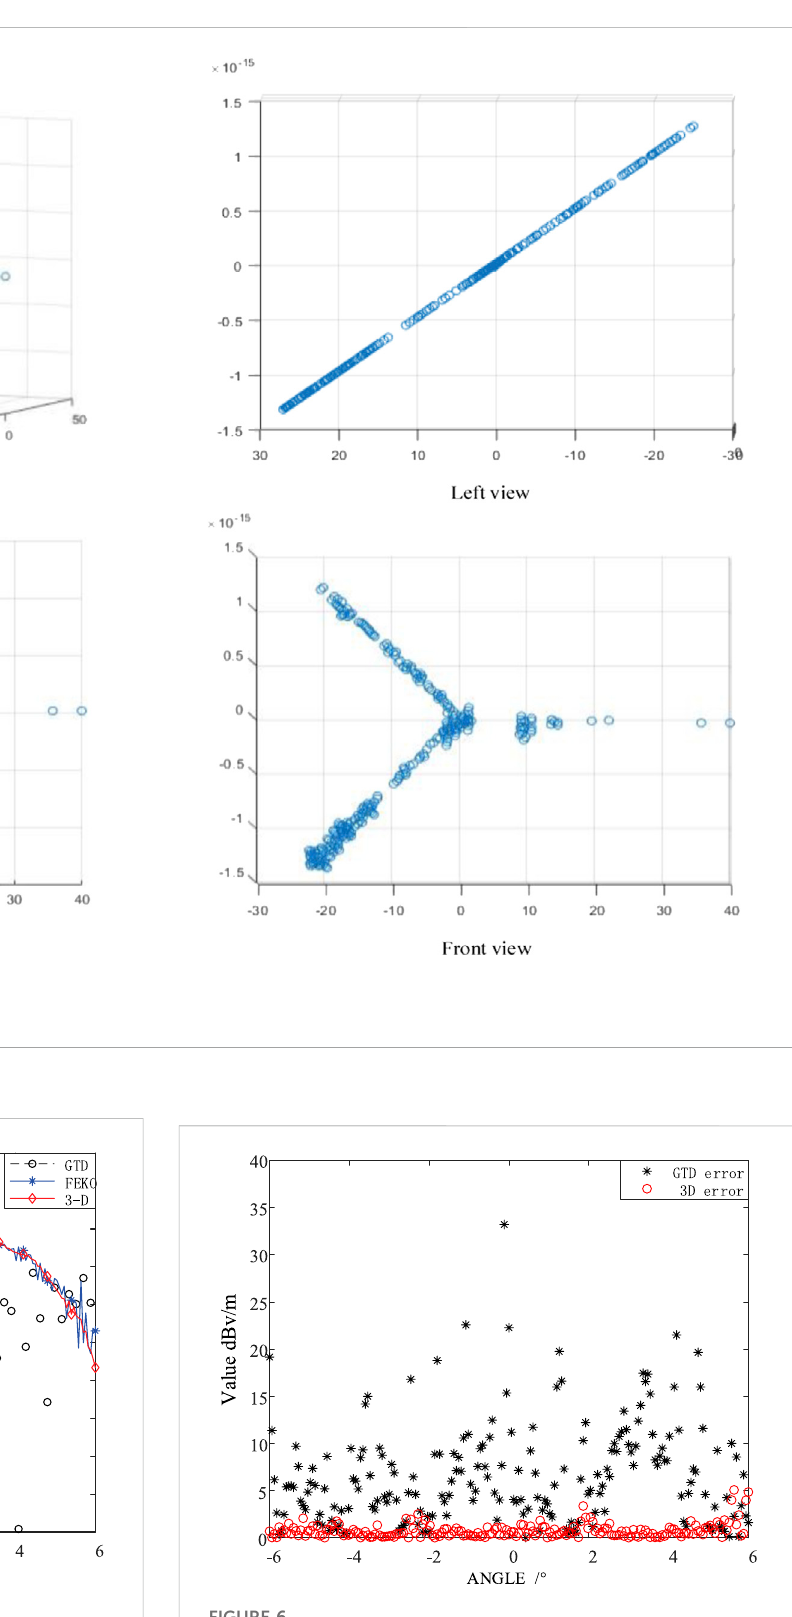
FIGURE 5 The distribution of the scattered electric fi eld of the blade.